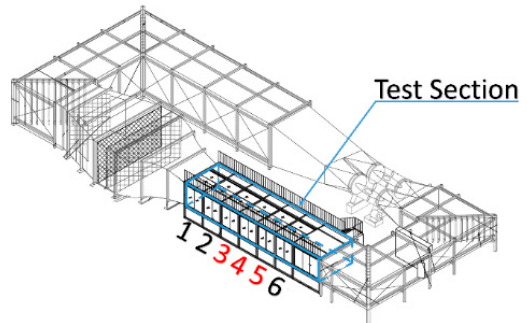
Figure 2. Boundary layer wind tunnel [37,39].